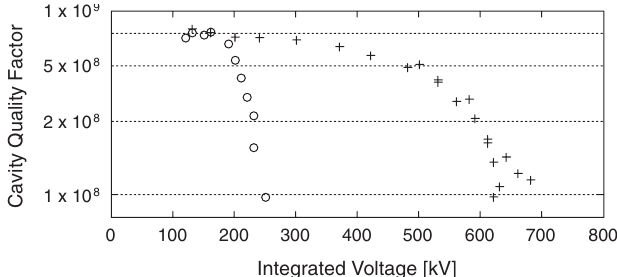
FIG. 12. Cavity Q during testing in September 2009 (circles) and October 2009